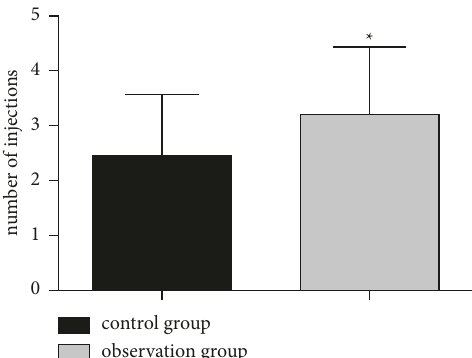
Figure 12: The average number of drug injections of the two groups of patients. Compared with the control group, ∗ P < 0 . 05.